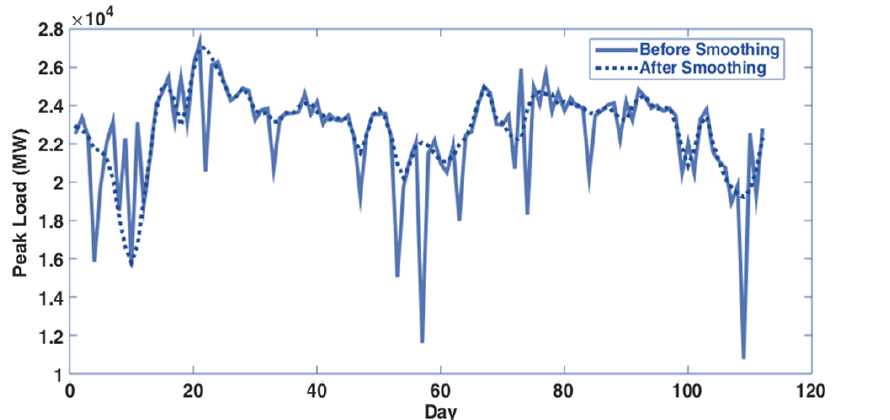
Figure 4. Relationship between original data and smoothed data.